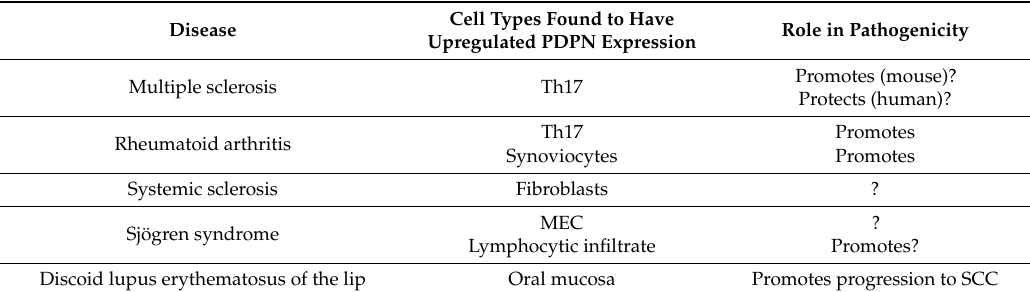
Table 1. Involvement of podoplanin (PDPN) in autoimmune diseases.